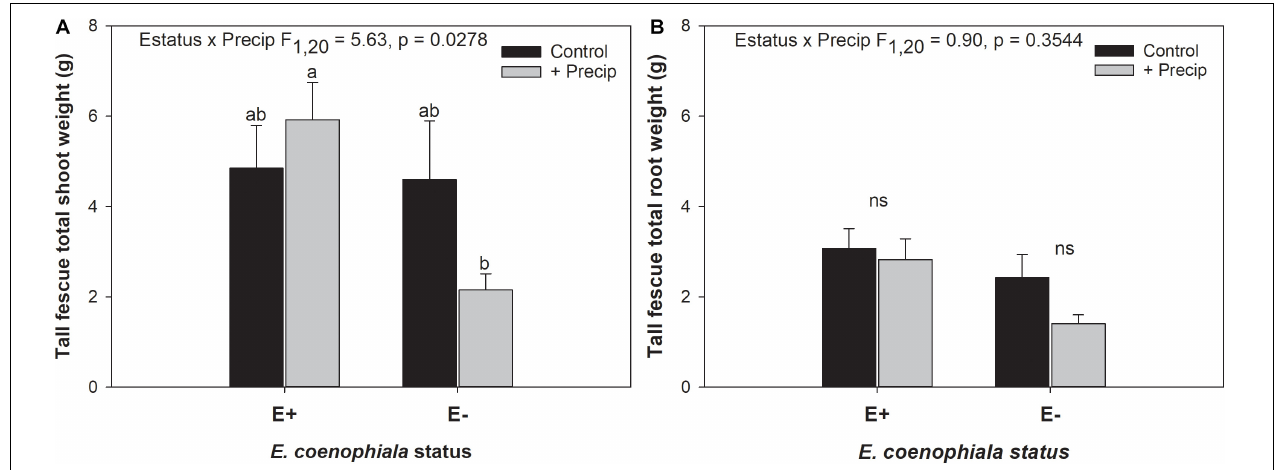
FIGURE 4 | Interactive effects of endophyte status and added precipitation on total (A) shoot weight and (B) root weight in tall fescue. Bars indicate means ± 1 S.E. Within panel (A) , bars sharing no common letter (a,b) indicate significant differences between means ( α = 0.05), Within panel (B) , lack of significant differences due to an interaction between endophyte status and added precipitation is indicated with